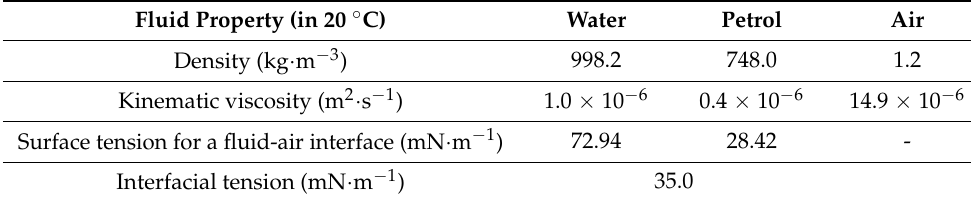
Table 1. Basic characteristics of the investigated fluids